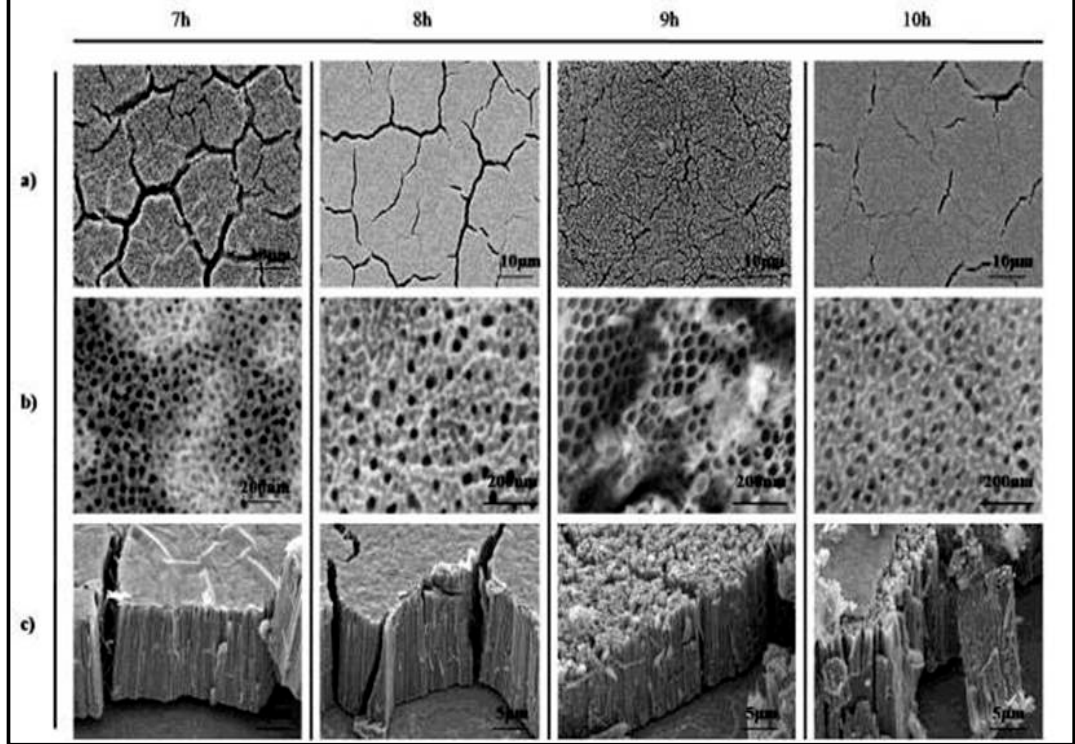
Figure 2. SEM images of Ti-30Ta alloy surface after anodization process in NH 4 F, 25% + glycerol at 30 V for 7, 8, 9, and 10 h. The annealing process was performed at 530 ◦ C (5 ◦ C / min) for 1 h. ( a ) Micrographs of superficial morphology. ( b ) Micrographs of superficial morphology in higher magnification. Nanotubes cover the substract surface. ( c ) Tilted micrographs of superficial morphology. They show the morphology height. Table 1. Diameter and length measurements of the nanotubes formed on the surface of the Ti-30Ta alloy a SEM images of Ti-30Ta alloy surface after anodization process in NH 4 F 0.25% + glycerol at 30 V for 4, 5, 6, 7, 8, 9, and 10 h. The annealing process was performed at 530 ◦ C (5 ◦ C / min) for 1 h.